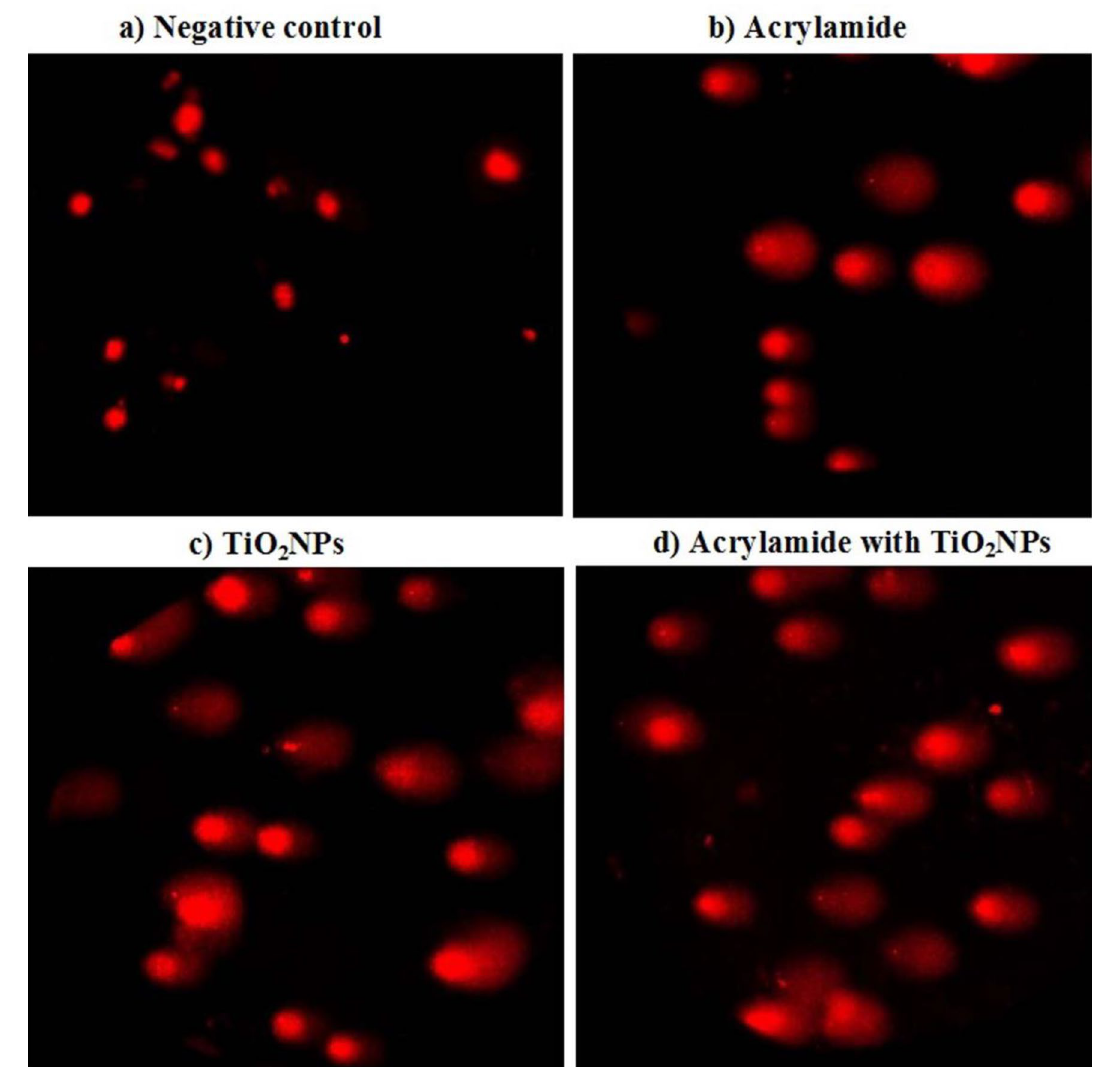
Figure 3. Representative photomicrograph for the observed comet nuclei in the brain tissues of ( a ) negative control group, ( b ) acrylamide administrated group, ( c ) TiO 2 NPs administrated group, and ( d ) group administered acrylamide with TiO 2